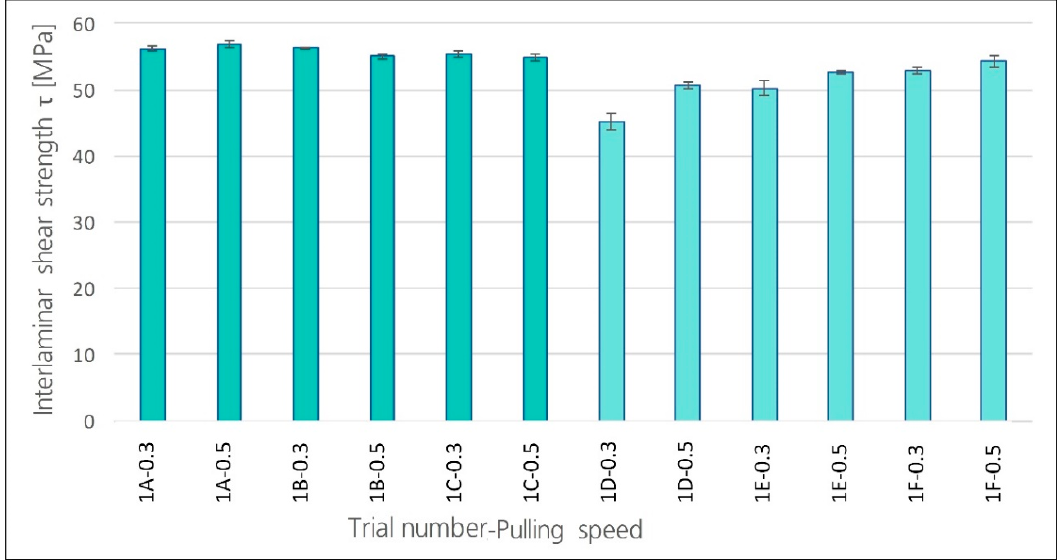
Figure 4. Interlaminar shear strength for different pulling speeds and resin mixing times .